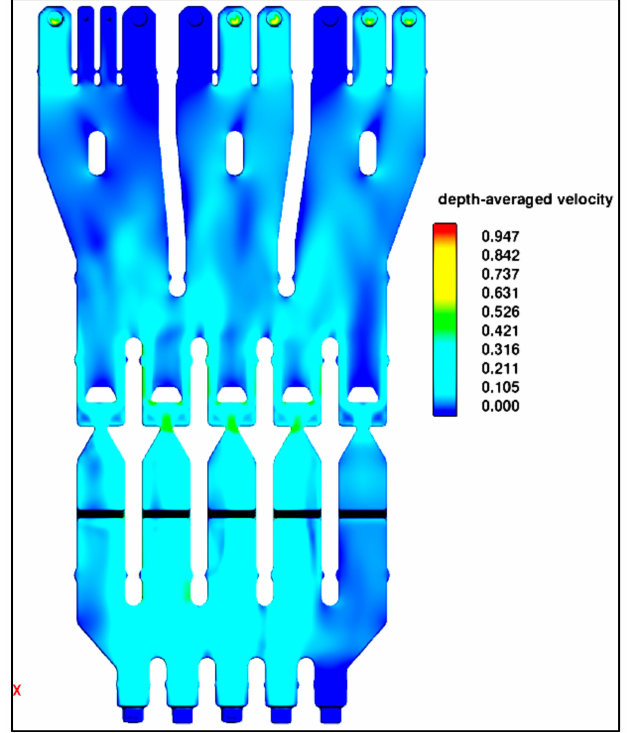
Figure 11. Velocity contours at the basin for scenario IV—3D